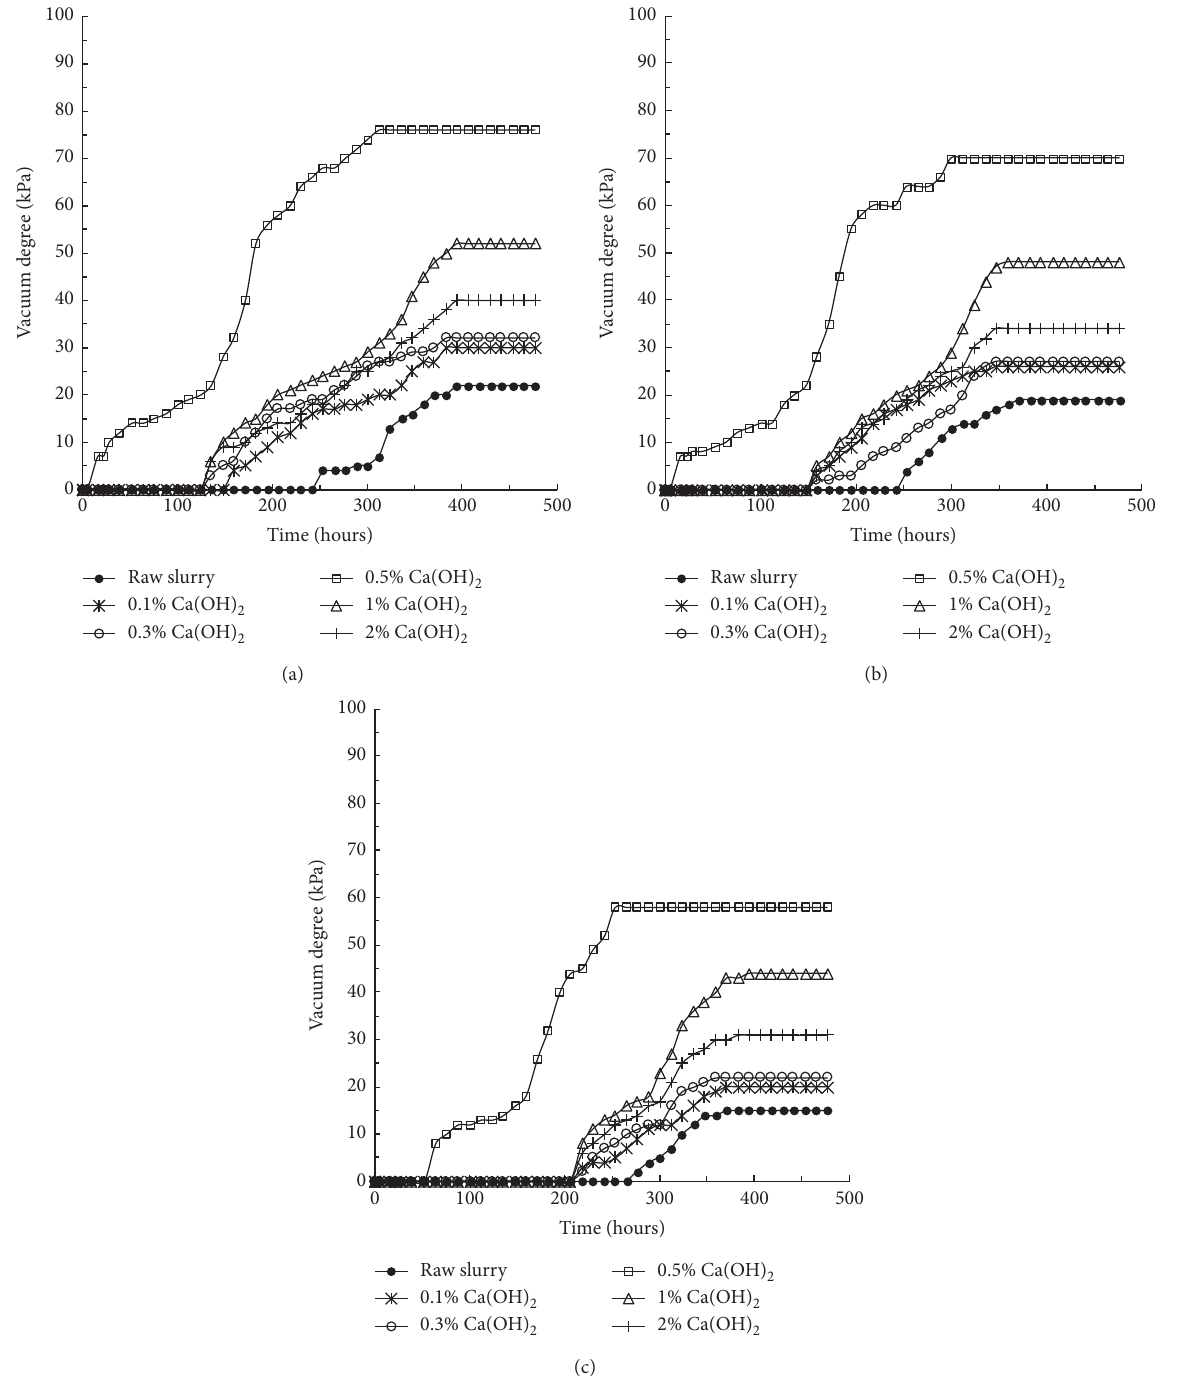
Figure 6: Variation of vacuum degree with distance to PVD for slurry with Ca(OH)